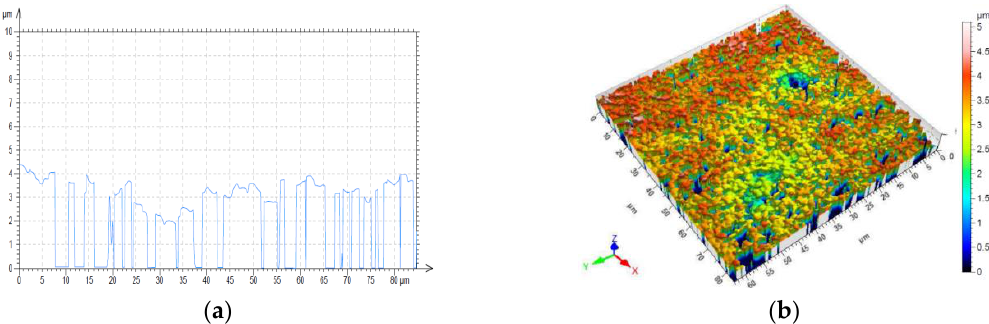
Figure 9. Surface roughness of conductive layer: ( a ) cross-section; ( b ) surface topography.